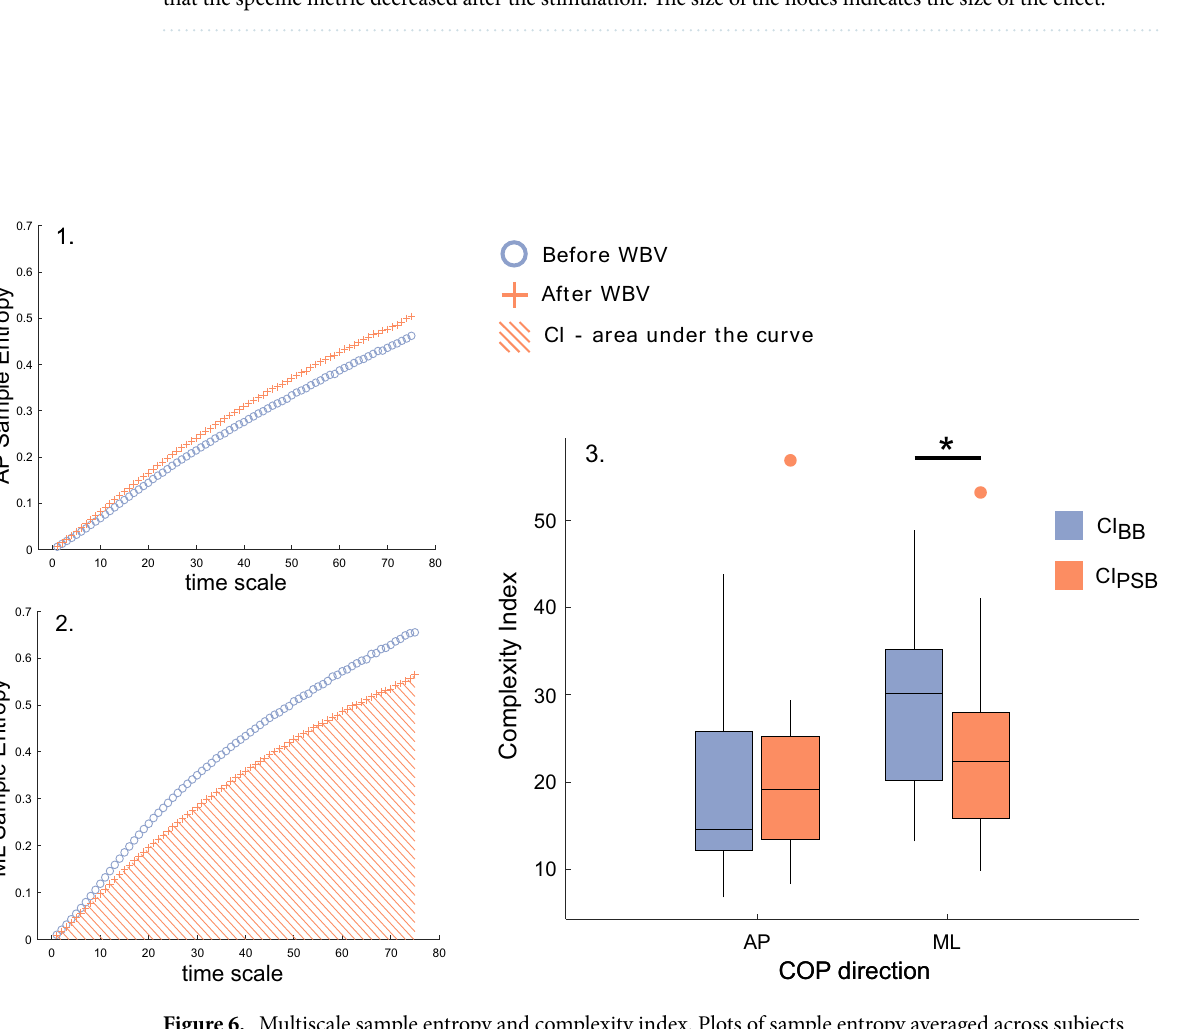
Figure 5. Node-wise analyses of muscle networks. Clustering coefficient results are reported for the frequency component where at least one node changed significantly between conditions. ( a ) Depicts the frequency component (2 Hz). ( b , c ) show the graph measure values for each node before and after the stimulation, respectively. ( d ) represents the statistical results of the node-wise analysis. The nodes that were significantly different ( p < 0.05) between conditions (pre vs post) are depicted and those that survived FDR correction are contoured by a yellow line. The colours of the nodes reflect the direction of the effect, with red nodes indicating that the specific metric decreased after the stimulation. The size of the nodes indicates the size of the effect.